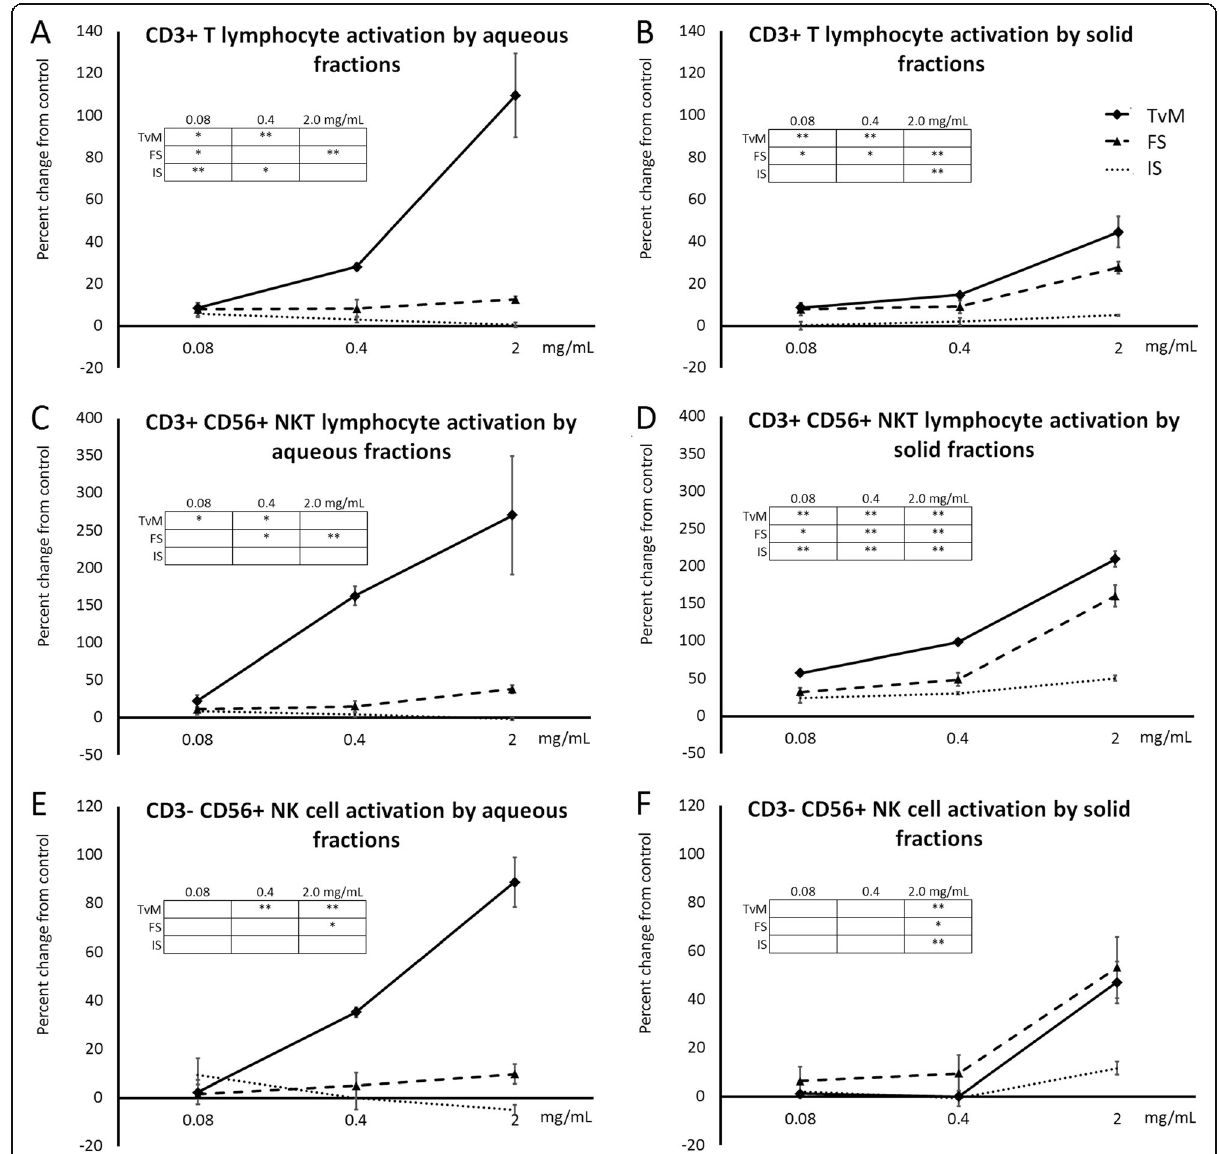
Fig. 4 Induction of the CD69 cellular activation marker on immune cell subsets in human PBMC cultures. The PBMC cultures were treated for 24h in the presence of serial dilutions of Trametes versicolor mycelium (TvM), fermented substrate (FS), or initial substrate (IS). The percent change when compared to untreated control cultures is shown for T lymphocytes ( a - b ), NKT cells ( c - d ), and NK cells ( e - f ). The effects of aqueous extracts are shown in a , c , and e , and the effects of the solid fractions are shown in B, d , and f . Data are shown for three doses tested (0.08, 0.4, and 2mg/mL), where the doses represent the amount of starting material used to produce a given fraction. Data are presented as mean±standard deviation of the percent change seen in triplicate cultures, and represents one of three separate experiments using PBMC cells from three different healthy human donors. Positive controls included LPS and IL-2. The mean±standard deviation percent change induced by LPS were 19±2.1% for T lymphocytes, 54±8.3% for NKT cells, and 114±10% for NK cells. The mean±standard deviation percent change induced by IL-2 were 39±0.9% for T lymphocytes, 150±25% for NKT cells, and 446±60.0% for NK cells. Inserted tables: Statistical significance is indicated as * for P <0.05 and ** for P